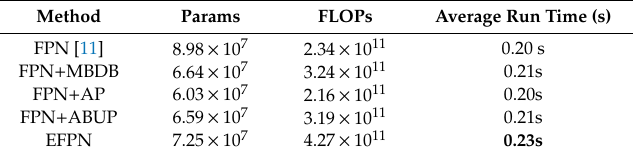
Table 3. The detailed comparison at each operation stage of